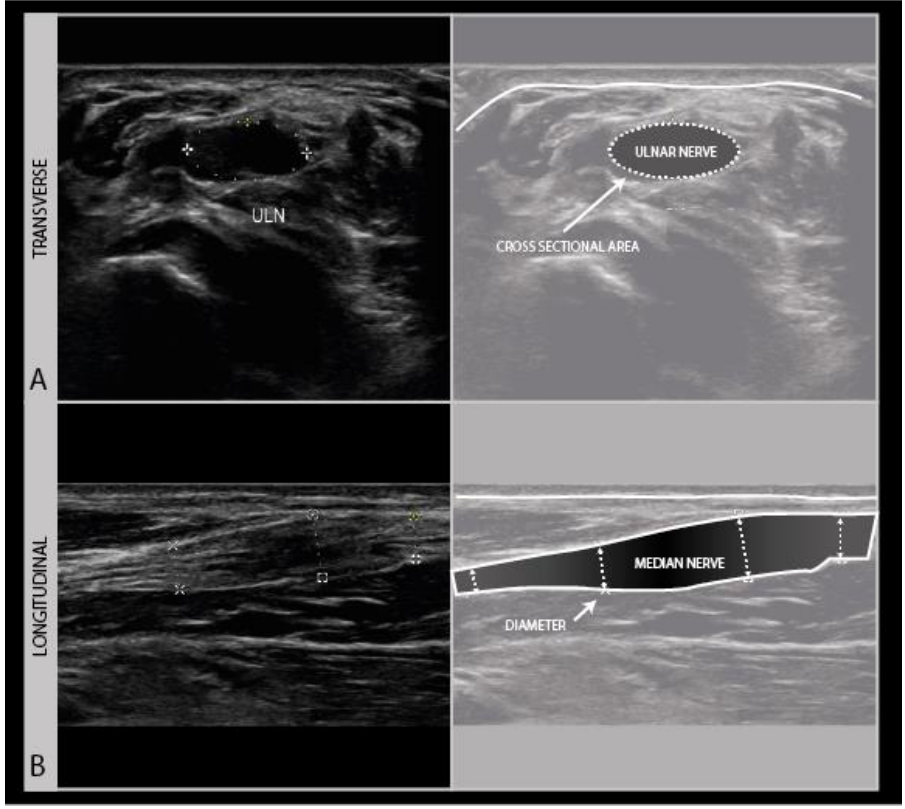
Figure 3. Image examples of transverse cross-sectional area (CSA) ( A ) versus longitudinal diameter measurement ( B ). A: distal ulnar neuroma; B: distal median nerve neuroma (adult male with a crush injury of the distal forearm). ULN = ulnar nerve.